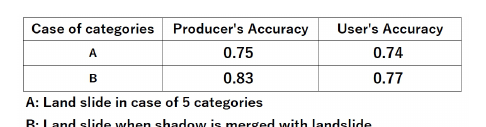
Table 2. Evaluation of classification accuracy of landslide classification